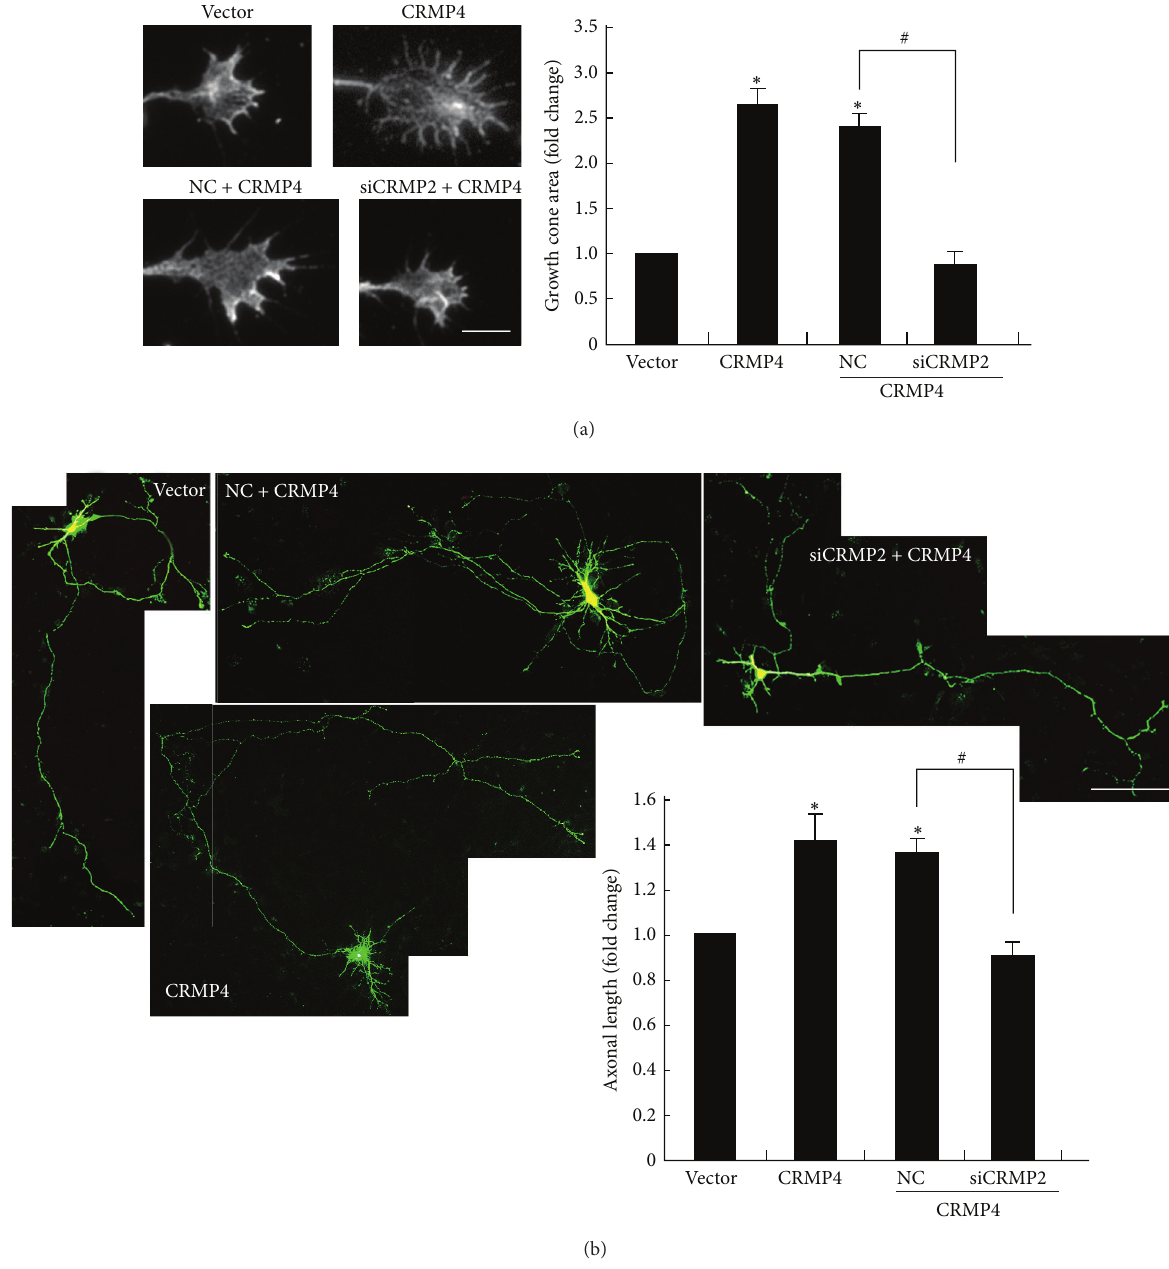
Figure 5: Genetic silencing of CRMP2 inhibits the promoting effect of CRMP4 on growth cone development and axonal elongation. (a) Representative images of growth cones with indicated transfections are shown. Scale bar: 10 𝜇 m. Relative ratio of the growth cone area was measured and shown in the right panel. Mean ± SEM, 𝑛 = 3 ; ∗ 𝑃 < 0.05 versus vector control; # 𝑃 < 0.05 versus NC. (b) Hippocampal neurons were transfected with the indicated plasmids or siRNA fragments together with GFP. Representative images of GFP staining are shown. Axon length was measured as the mean ± SEM from three independent experiments ( 𝑛 = 3 ). ∗ 𝑃 < 0.05 versus vector control; # 𝑃 < 0.05 versus NC. Scale bar: 100 𝜇